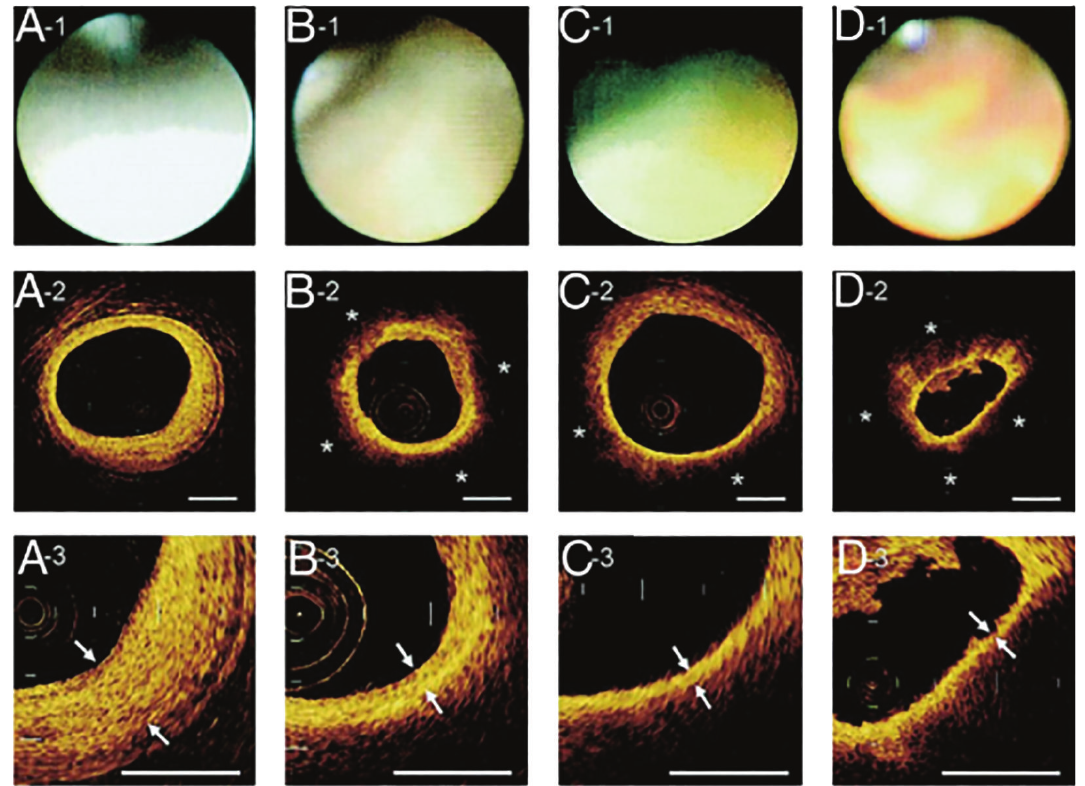
Figure 6: Angioscopic and corresponding OCT images obtained in patients presenting with acute coronary syndrome. In the angioscopic images, plaque color is graded as white (A-1), light yellow (B-1), yellow (C-1), or intensive yellow (D-1). In the optical coherence tomography (OCT) images, a lipid pool (*) is characterized by a signal-poor region (A-2, B-2, C-2, and D-2). The fibrous cap is identified as a signal-rich region between the coronary artery lumen and inner border of lipid pool in the OCT image, and its thickness is measured at the thinnest part (A-3, B-3, C-3, and D-3; arrows). Reprinted with permission from Kubo et al.